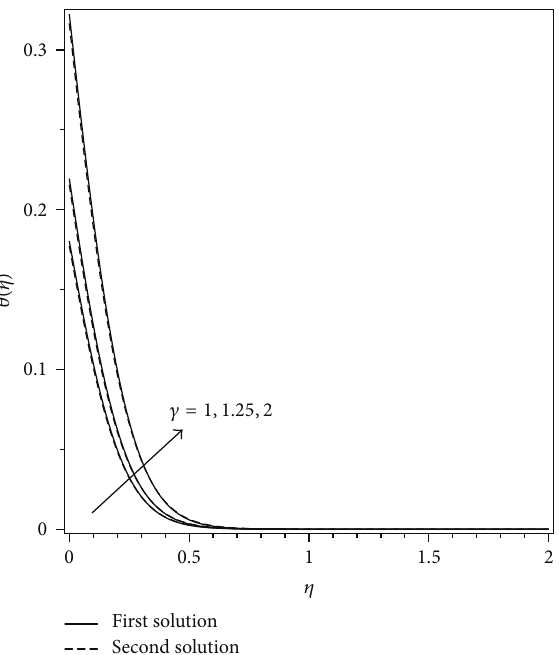
Figure 8: Temperature profiles for different values of 𝛾 when Nb = Nt = 0.5, Le = 2, Pr = 6.8, 𝜎 = − 0.1, and S = 2.